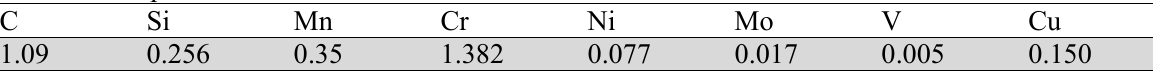
Chemical composition of AISI 52100